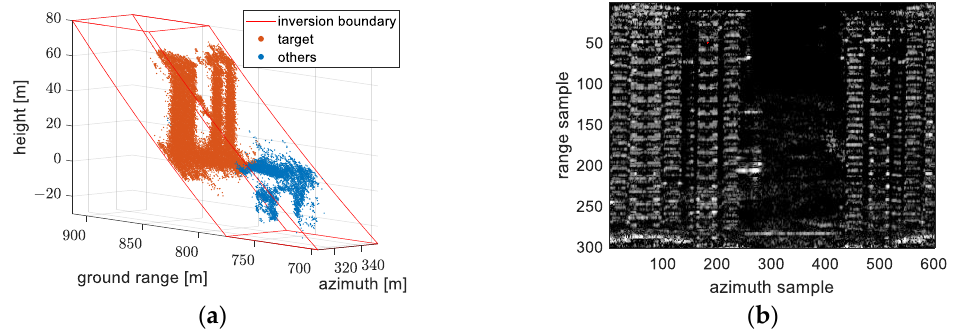
Figure 24. The target extracted from the selected region in experiment 2: ( a ) 3-D point cloud containing the target and others; ( b ) 2-D SAR image corresponding to the